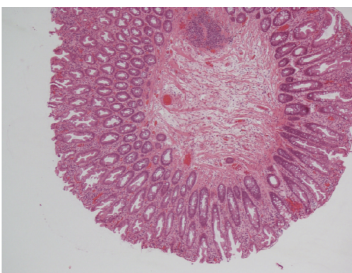
(a) Negative control, Blood DNA